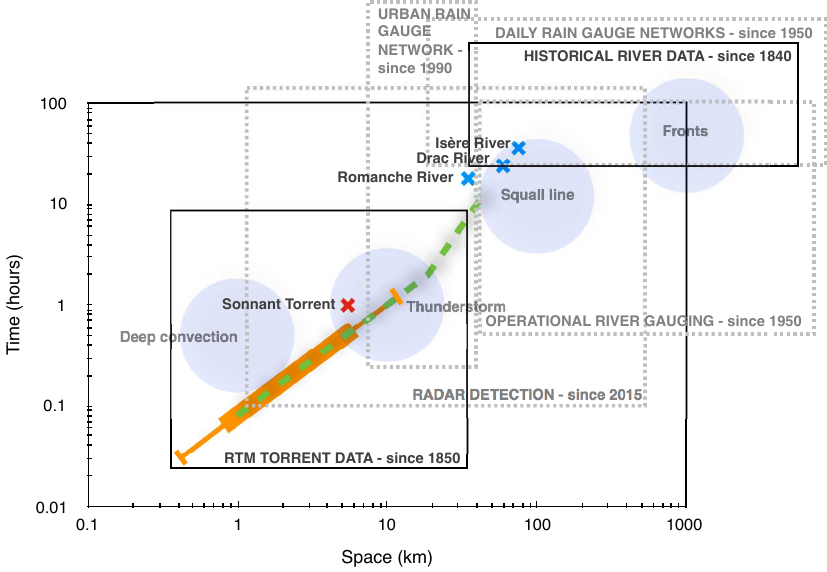
Figure 2. Logarithmic (base 10) window showing the instrumental time and space resolution and their period of availability in the study area of Grenoble agglomeration, France (dotted grey rectangles— the upper time-limit of the rectangles is not meaningful). The time and space characteristics of four atmospheric processes controlling rainfall formation at different scales are shaded in light blue after [33]. The relationship established by [34] from extreme flash floods in Europe between the response time of a basin and its size is represented in bold dotted green. From the cited literature, we also show the response times of three rivers (blue crosses—after hydrographs shown in [31]) and one torrent (red cross—after [30]) of the agglomeration. The size of the Metropolitan torrential units of the RTM database are represented in orange (the bold part of the line represents the inter-quantiles 10% to 90% and the thin part the min–max interval—the response time is taken from the relationship of [34]). The two continuous grey rectangles summarize the datasets used in this